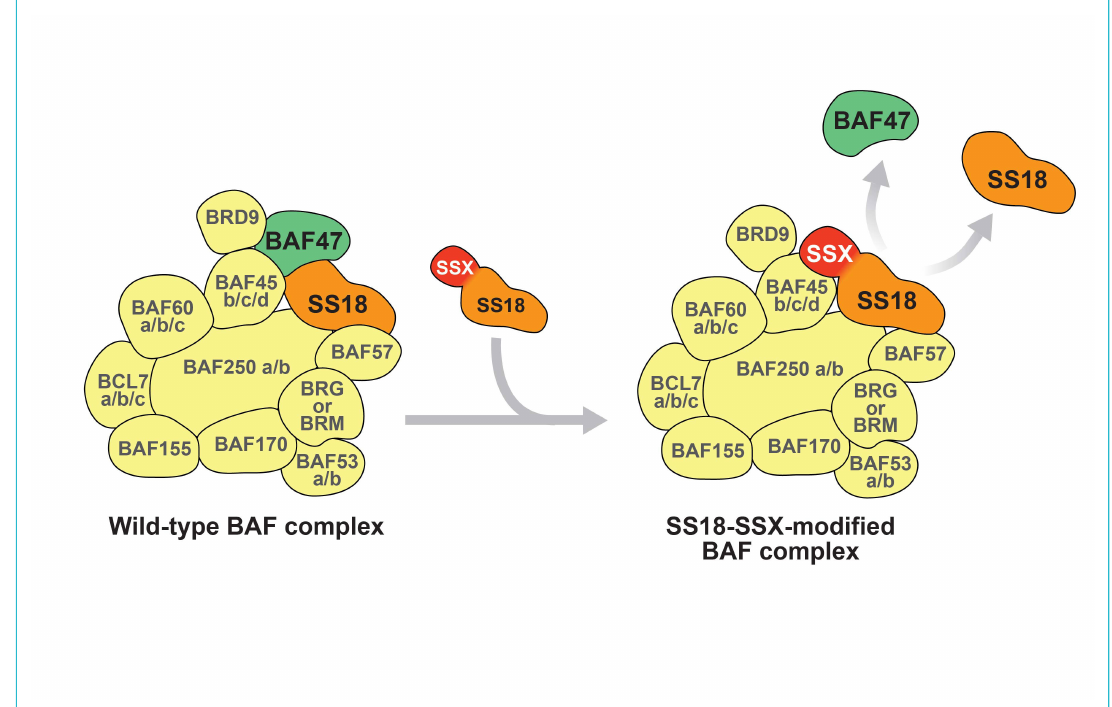
Figure 3: Relationship between SS18, SS18-SSX and the BAF complex. SS18 is an integral part of the wt BAF complex (left). The SS18-SSX fusion protein displaces wt SS18 and BAF47 within the complex